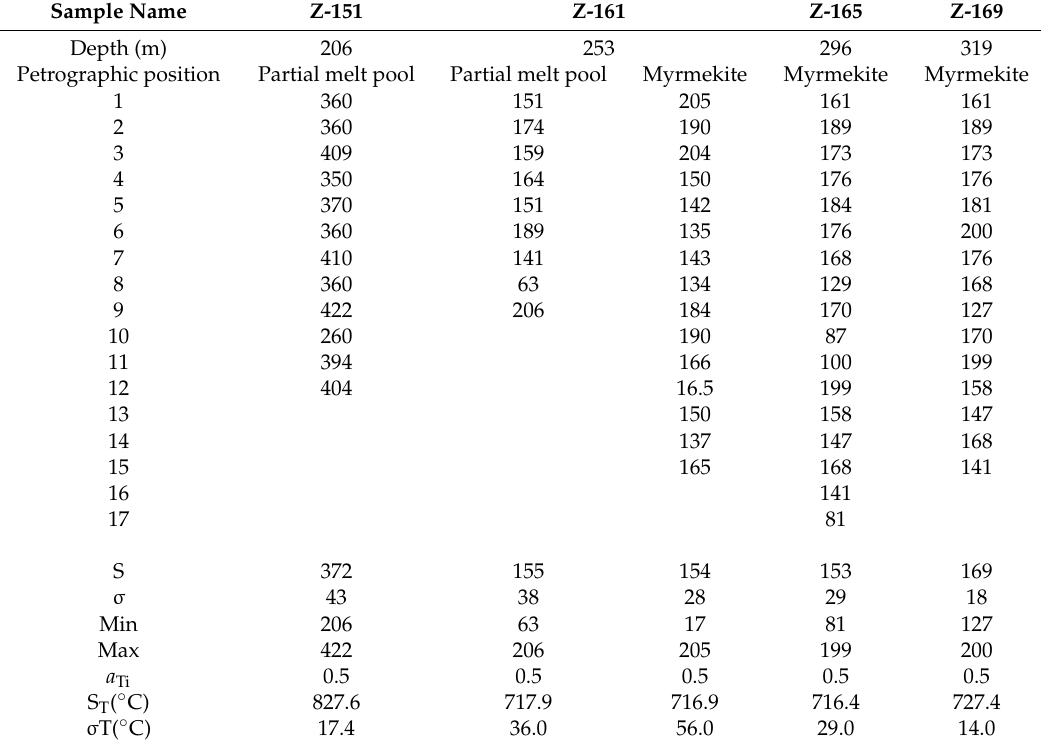
Table 2. Titanium content (given in ppm) of the analyzed quartz crystals in the partial melts and calculated crystallization temperatures. Average error of the individual measurements is ± 8%. (S = average of the individual Ti concentration measurements, given in ppm; σ = standard deviation of the titanium concentrations; a Ti = titanium activity in the quartz; S T ( ◦ C) = temperature calculated from the average Ti concentrations given in Celsius degree; σ T ( ◦ C) = standard deviation of the temperature calculation, given in Celsius